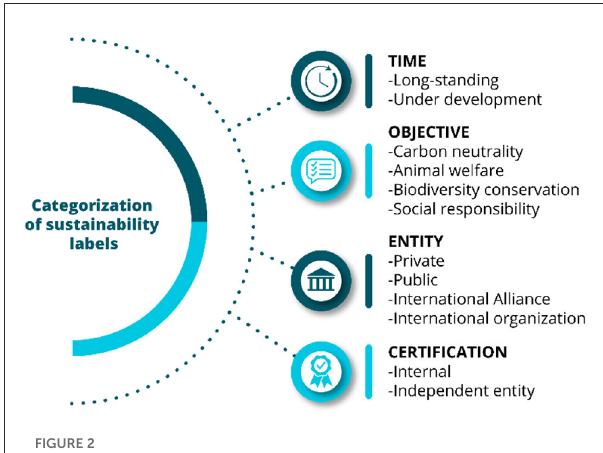
FIGURE2 Categorization of sustainability labels.